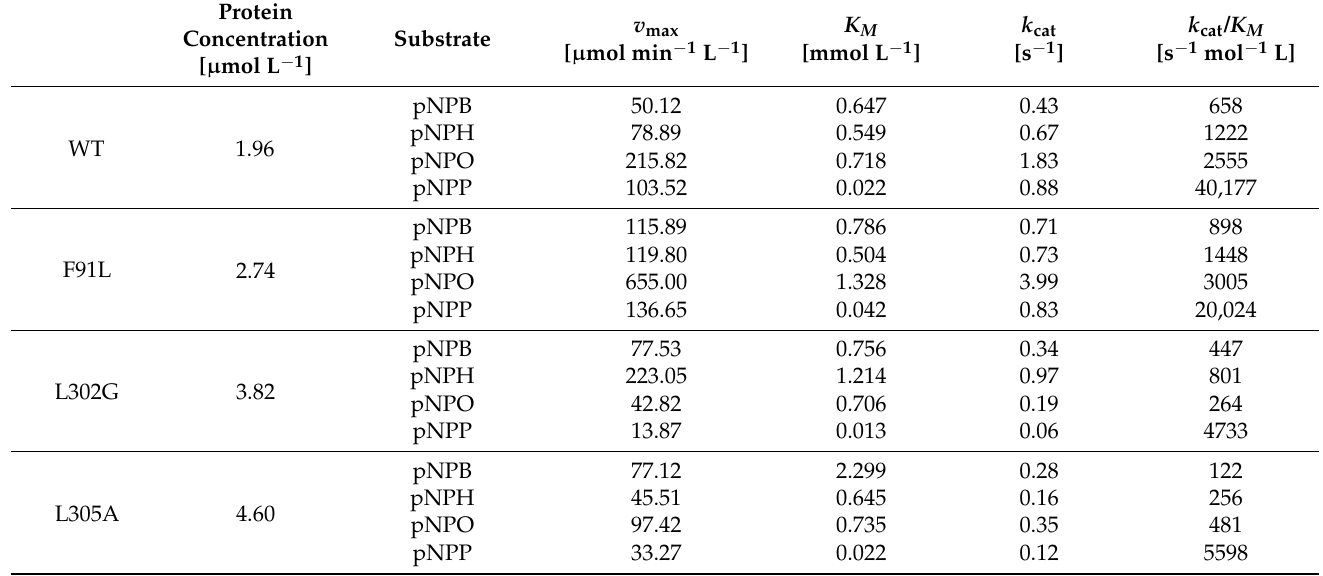
Table 2. Overview of the kinetic data of PCI_Lip WT and mutants F91L, L302G, and L305A against selected model substrates. Listed are the maximum velocity ( v max ), the Michaelis-Menten constant ( K M ), the turnover number ( k cat ), the catalytic efficiency ( k cat / K M ), and the protein concentration in all kinetic experiments, which were used for the calculation of k cat